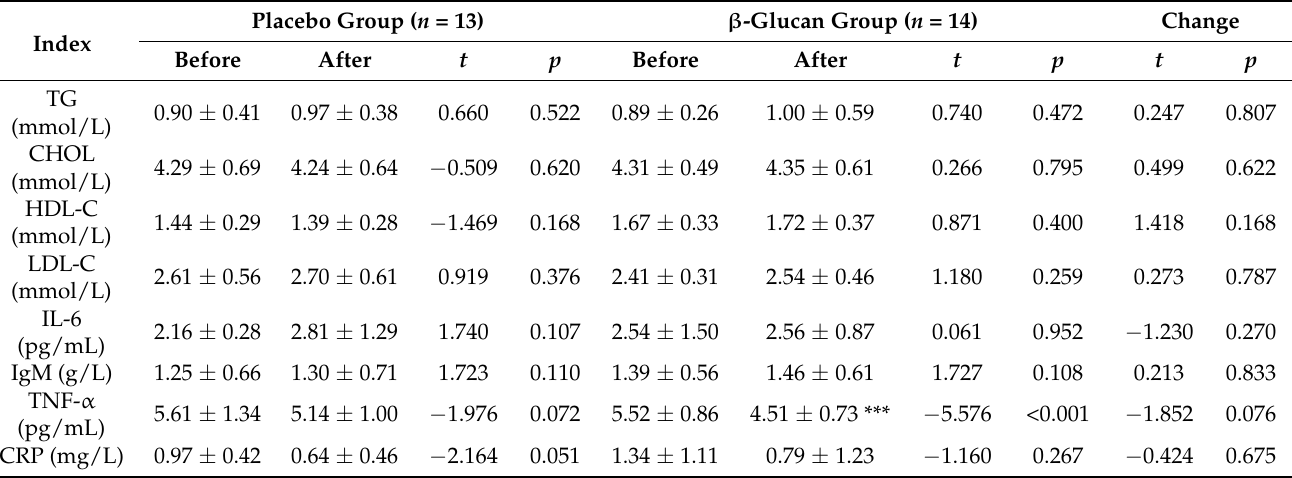
Table 4. Comparison of the results of four indicators of blood lipids before and after the intervention in the two groups of